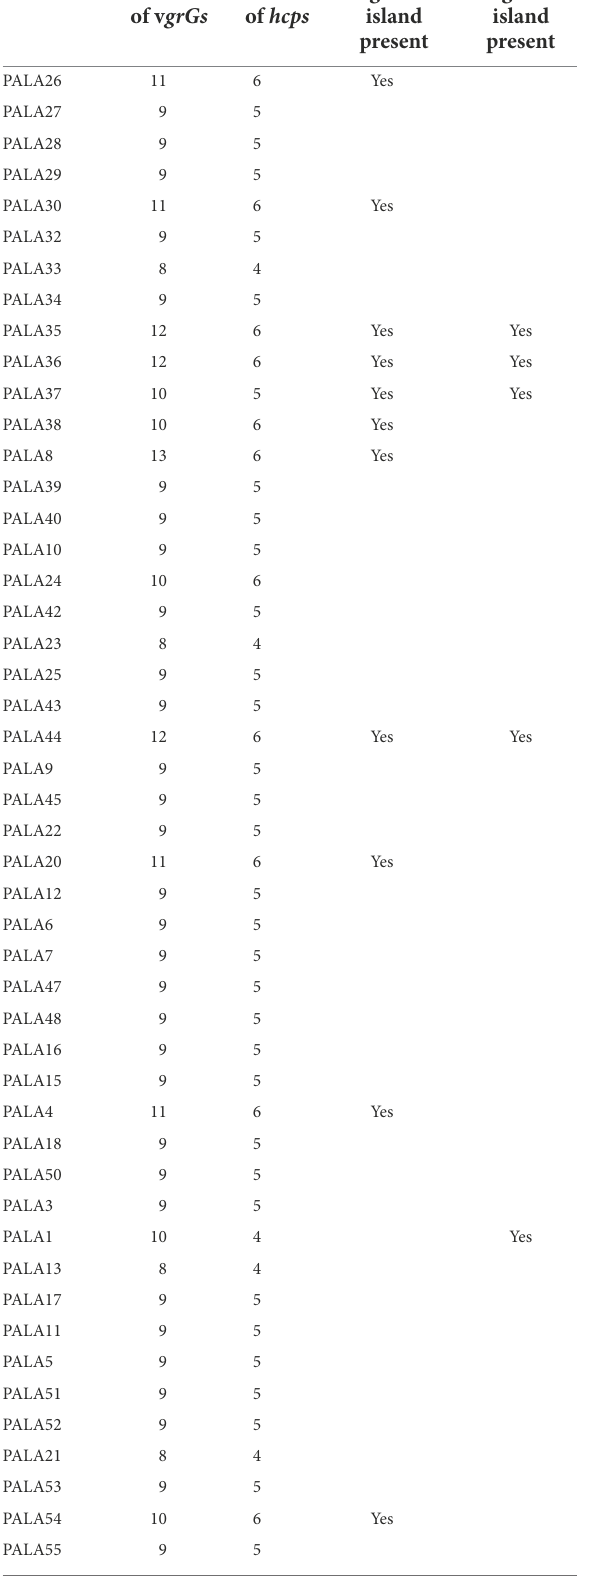
TABLE 1 Abundance of vgrG and hcp genes within the 52 P. aeruginosa genomes under study. Isolate